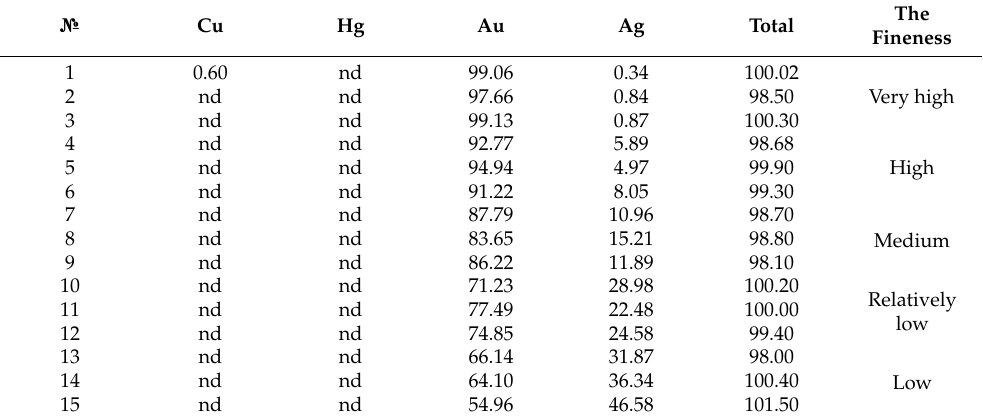
Table 2. The most typical analyses of the chemical composition of native gold of the Nebaibyt river placer on gradations of gold fineness.